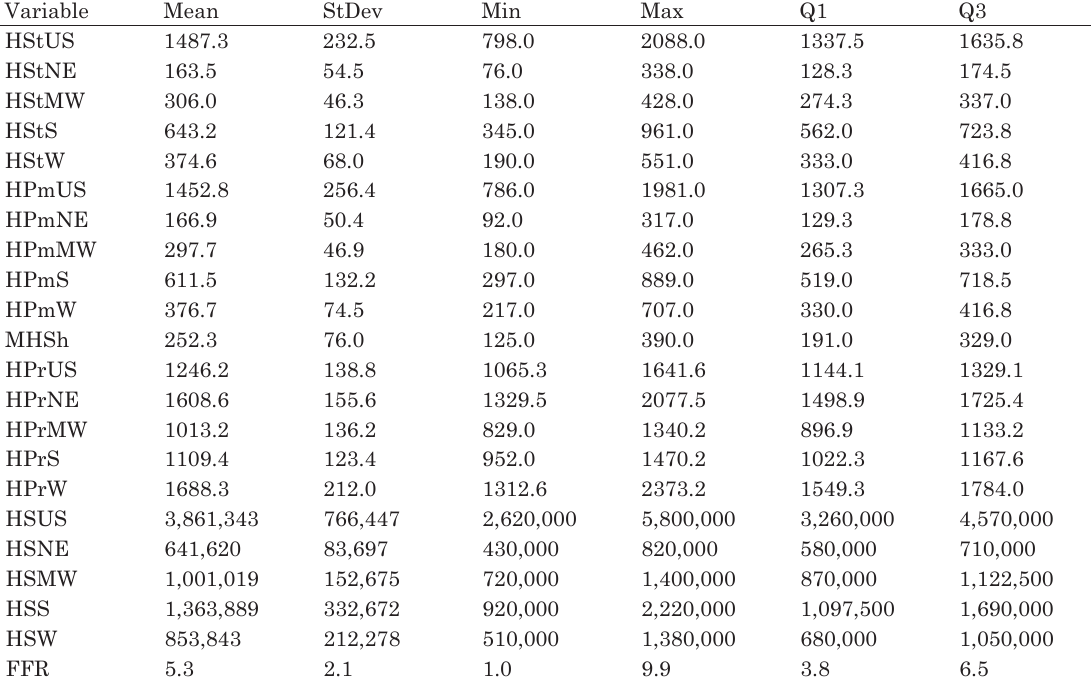
table 1. summary statistics for the housing variables